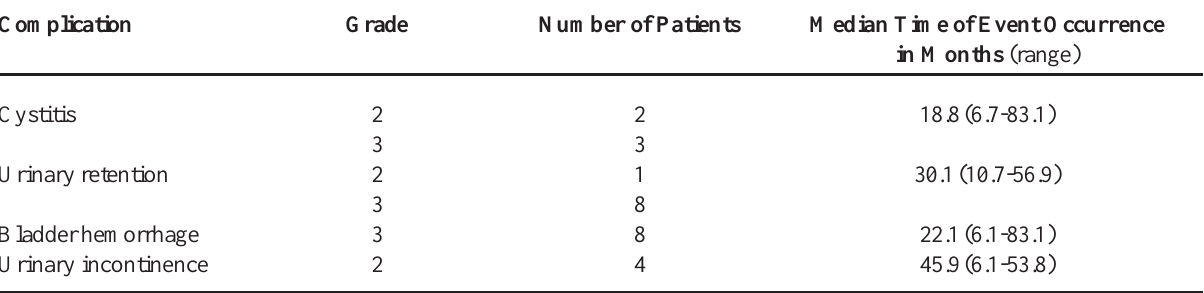
Table 2 – Time and number of patients with urinary complications after 3DCRT.